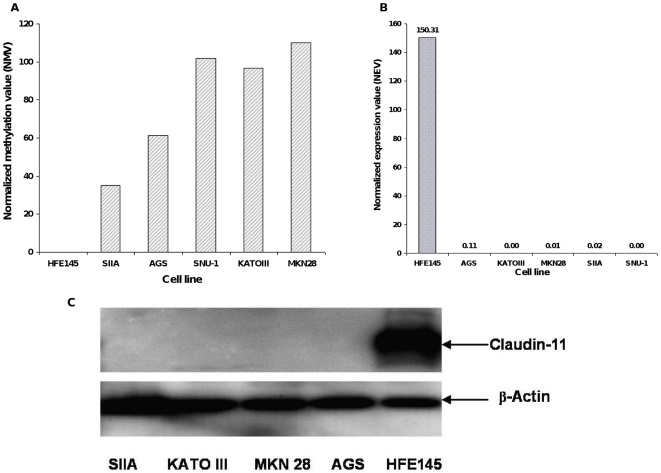
Analysis of promoter methylation, mRNA and protein expression of claudin-11 in gastric cell lines.This figure illustrates the claudin-11 promoter methylation, mRNA expression levels and protein expression in gastric cells lines. A) Quantitative methylation-specific PCR (qMSP) for CLDN11. Genomic DNAs isolated from immortalized human normal gastric epithelial cells (HFE145) and GC cell lines AGS, SIIA, MKN28, KATOIII, and SNU-1 obtained from ATCC were analyzed by qMSP. This Figure illustrates that the promoter region of CLDN11 gene is hypermethylated in all GC cell lines relative to HFE145 cells. B) CLDN11 mRNA expression in gastric cell lines. Total RNAs from different gastric cell lines were subjected to quantitative real-time RT-PCR analysis. As can be seen in this figure, HFE145 cells expressed very high levels of CLDN11 mRNA, while all five cancer cell lines tested had very low or undetectable CLDN11 mRNA expression. C) Western blot analysis of claudin-11 expression in gastric cell lines. Total cell lysates obtained from various gastric cell lines were probed with the anti-claudin-11 antibody. This figure illustrates that while the immortalized normal gastric epithelial cell line, HFE145, expressed abundant claudin-11 protein, it could not be detected in various GC cell lines. Anti-β-actin antibody was used as a loading control.